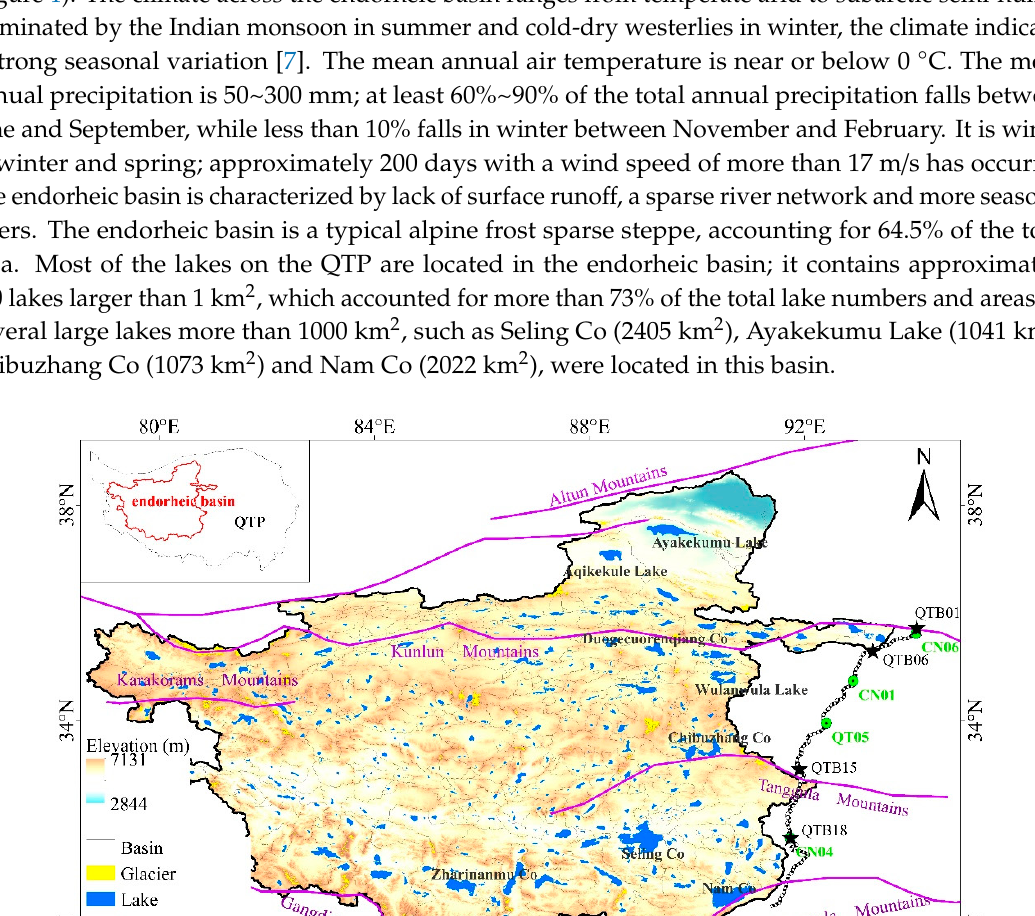
Figure 1. Schematic representation of the study area. The glacier data was from the Second Glacier Inventory Dataset of China (http: // westdc.westgis.ac.cn). Lake sizes was from 2017 in this paper. The Digital Elevation Model was loaded from ASTER GDEM version 2.0 with a spatial resolution of 30 m (http: // www.gscloud.cn), and the drainage basins were also derived from ASTER GDEM version